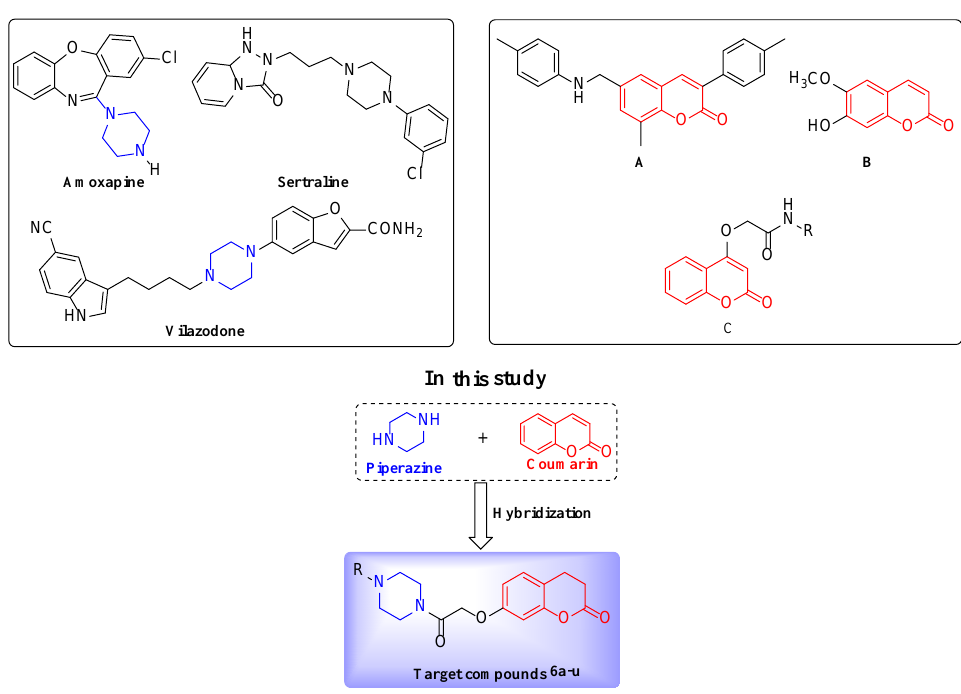
Figure 1. Design strategy for target compounds 6a–u.